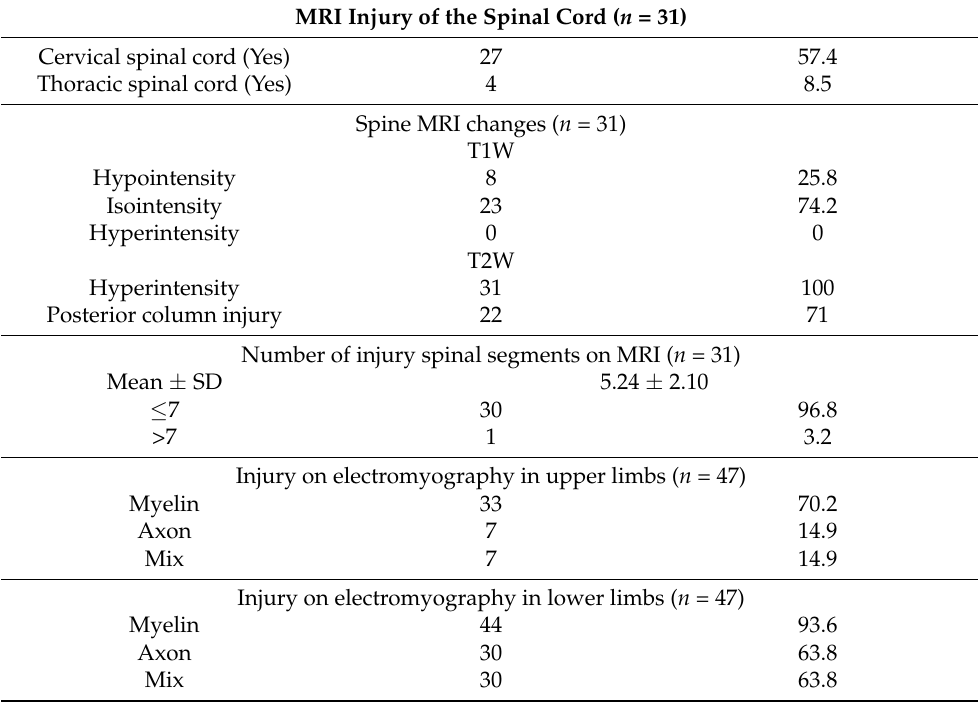
Table 3. MRI and electromyography data of N 2 O abuse patients included in this study ( n = 47).